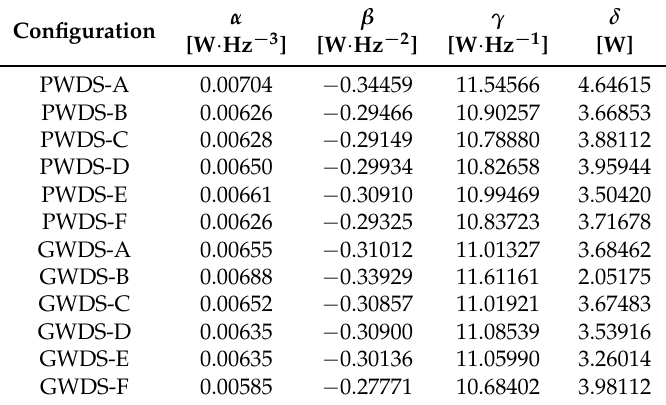
Table 1. Constants for Equation (17).